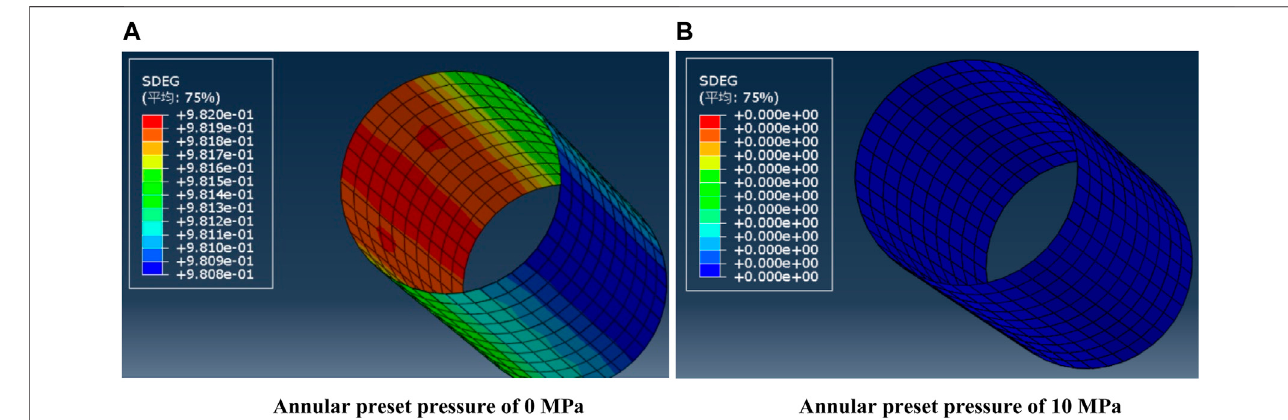
FIGURE 8 | Simulation results of pressure relief in